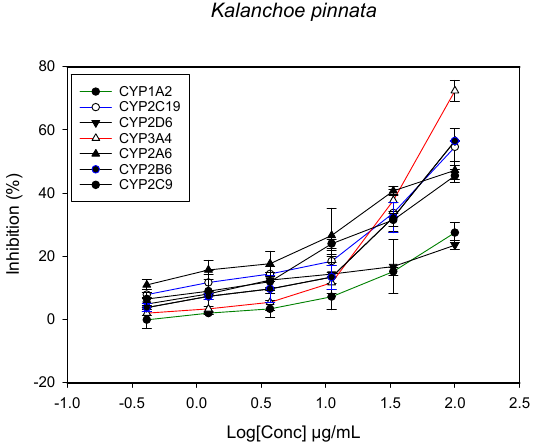
Figure 3. The inhibitory effect of graded concentrations of the extracts of K. pinnata on the metabolic activity of cytochrome P450 enzymes.